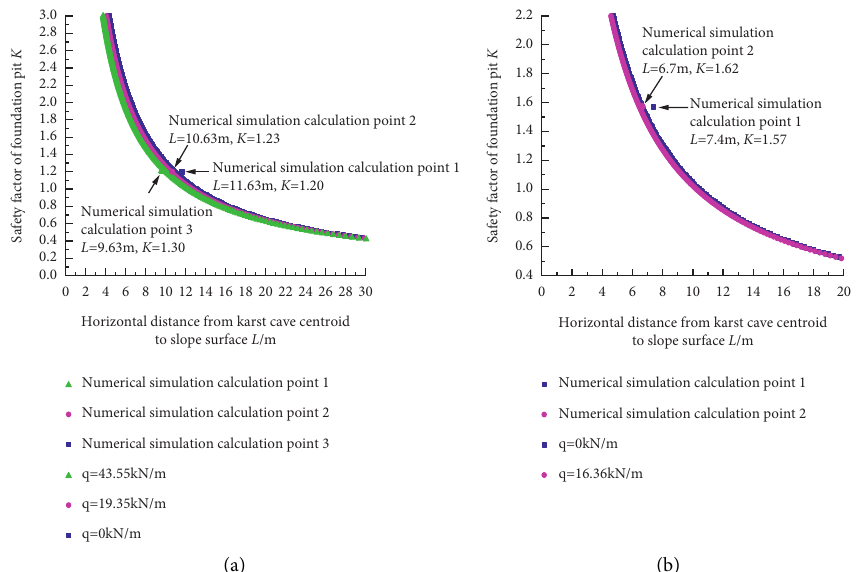
Figure 4: Verification of calculation equations for rock slopes containing structural planes and karst caves based on the upper bound method (Figure 4 is reproduced from Jin Xu et al. 2021). (a) Comparison and verification of numerical analysis and theoretical calculations for a structural plane with a dip angle of 60 ° . (b) Comparison and verification of numerical analysis and theoretical calculation for a structural plane with a dip angle of 70 ° .